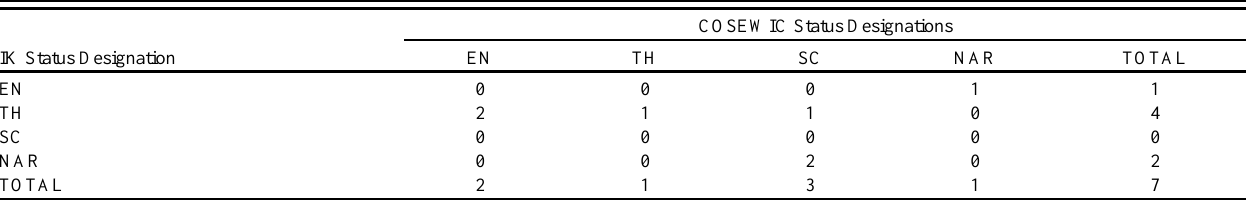
Table 3 . Inuit Knowledge (IK) and Committee on the Status of Endangered Wildlife in Canada (COSEWIC) status designation comparison summary. See Appendix 1 for glossary of acronyms.